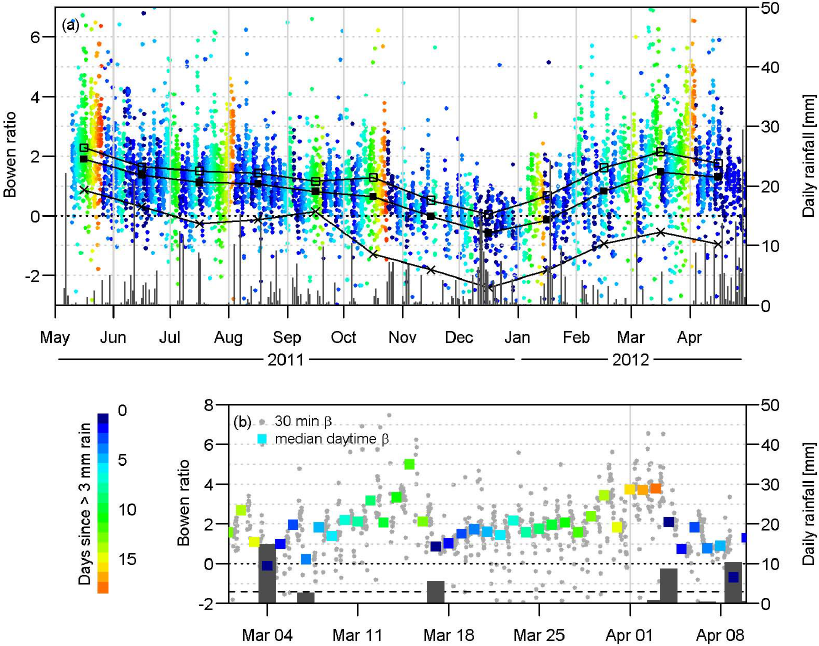
Fig. 7. Daytime ( K ↓ > 5Wm − 2 ) Bowen ratio (30min) coloured by number of days since rainfall (exceeding 3mm) for (a) the study period and (b) spring 2012. Daily rainfall (bars) corresponds to the right-hand axes. In (a) monthly median midday ( ± 2h) (open squares), monthly median daytime (solid squares) and monthly median nighttime ( Q ∗ < 0 and K ↓ ≤ 5Wm − 2 ) (crosses) Bowen ratios are plotted mid-month. In (b) the median daytime Bowen ratios for each day are shown (coloured